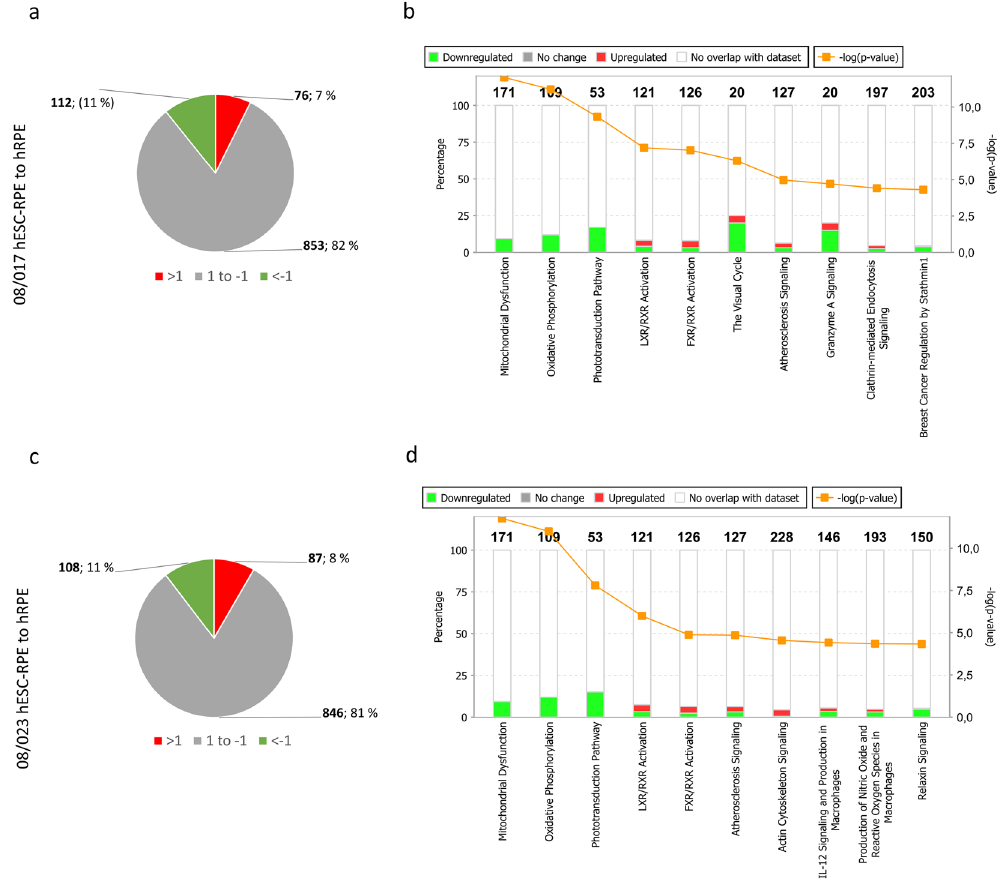
Figure 2. Protein expression differences between hESC-RPE and hRPE. The proportions of upregulated (green) and downregulated (red) proteins according to relative expression levels of the proteins compared to hRPE for ( a ) 08/017 hESC-RPE and ( c ) 08/023 hESC-RPE. For the majority of proteins in both RPE lines, there were no differences in expression level between hESC-RPE cells and hRPE (grey). Number of proteins included = 1041. Default settings of IPA were used to conduct core pathway analysis for the over- and underexpressed proteins (188 proteins for 08/017 and 195 proteins for 08/023). Ten enriched pathways with lowest p-values for the differentially expressed proteins in ( b ) 08/017 and ( d ) 08/023 hESC-RPE compared to hRPE. Total number of genes/proteins in each pathway shown on top of each bar and percentage present in the data analysed on the y-axis (left). Up- and downregulation of the proteins in the data is shown in red and green colours respectively, and p-value (orange line) is shown in -log scale, y-axis (right). Figures in ( b , c ) created with IPA (Qiagen)